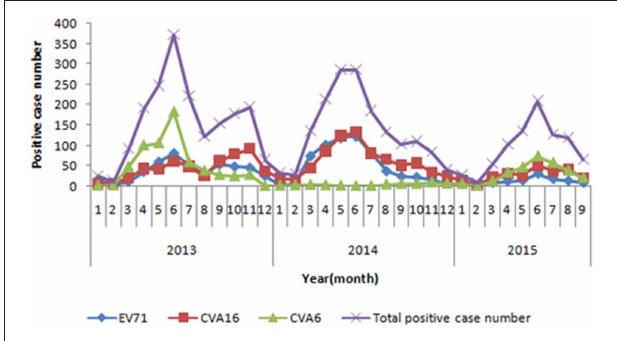
FIGURE 1 | Monthly distribution of enterovirus serotypes in laboratory-confirmed HFMD cases in Beijing, during 2013 and 2015.